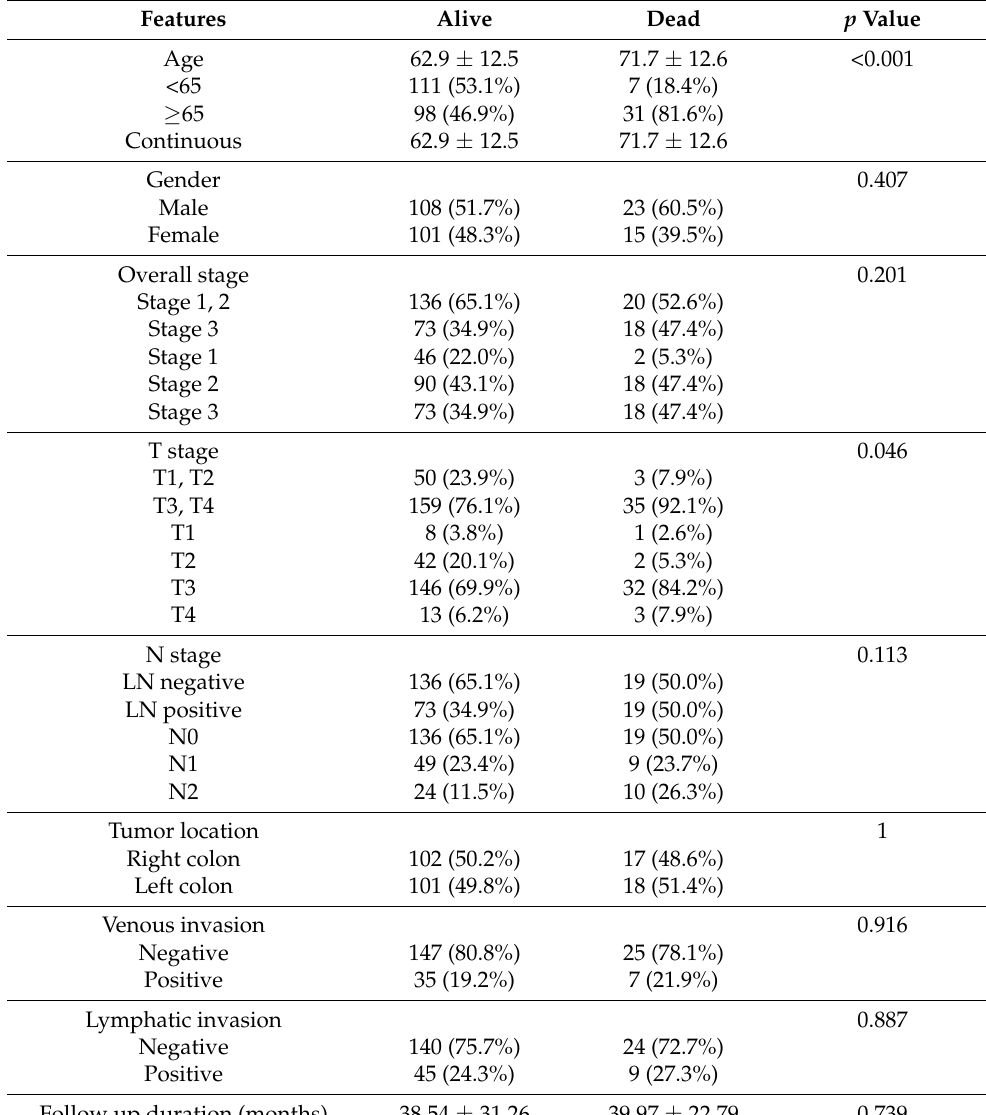
Table 1. Demographic features of the study